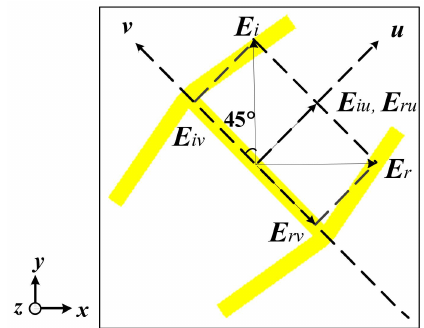
Figure 2. Intuitive scheme of y -to x -polarization conversion of the metasurface unit.